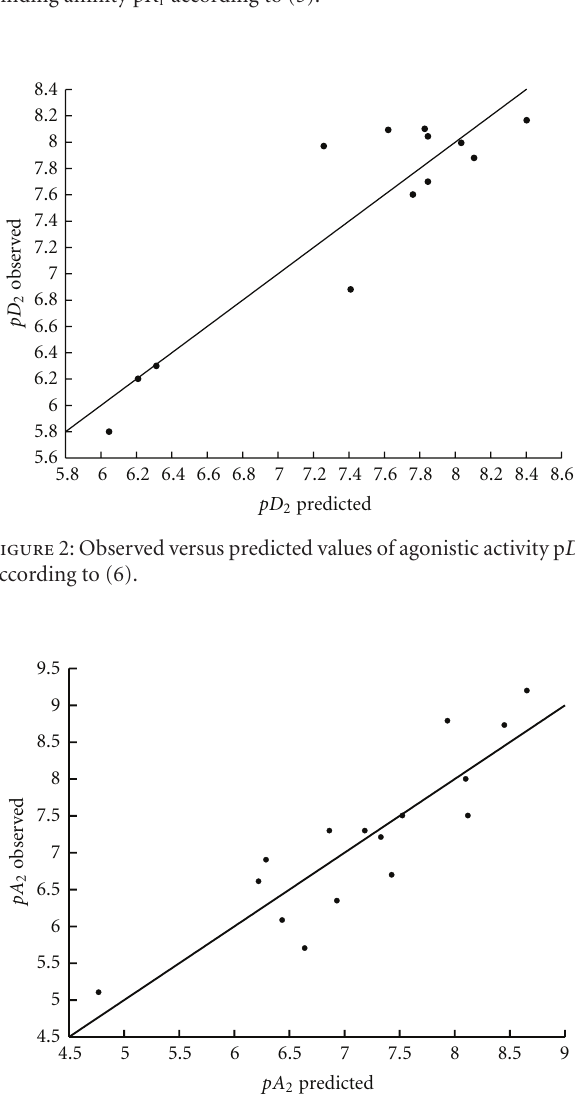
Figure 3: Observed versus predicted values of antagonistic activity p A 2 according to